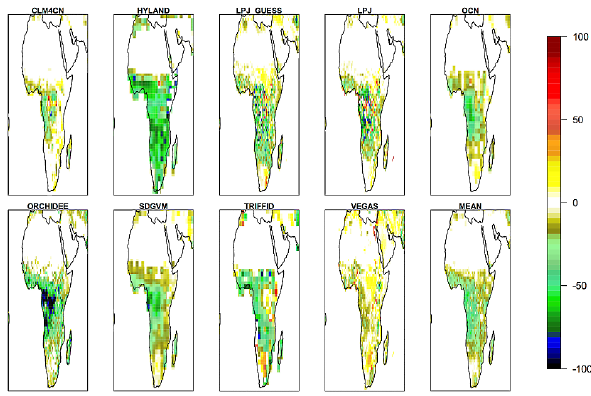
Fig. 5. Average net biome productivity (NBP) for each DGVM and model mean over the period 1990–2009, units, gCm − 2 yr − 1